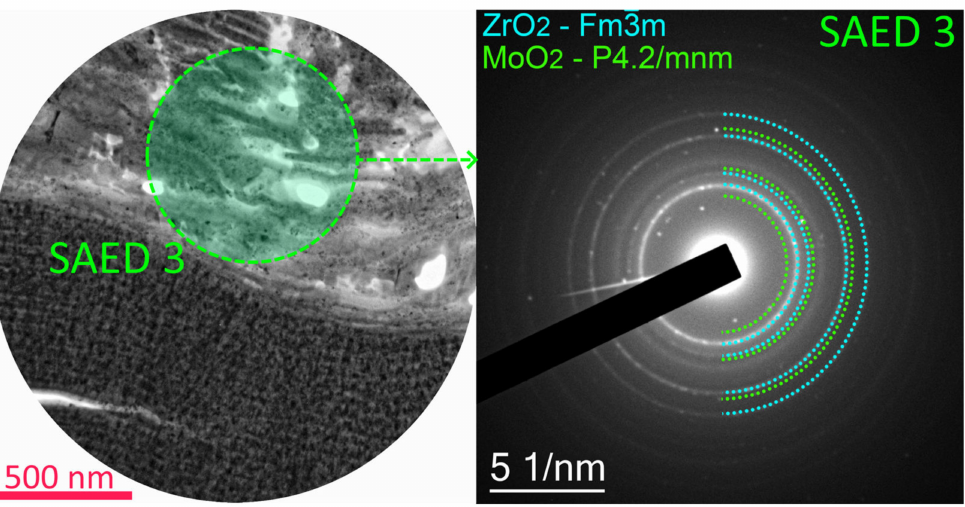
Figure 10. Analysis of the oxidation wear of the coating during the turning of Inconel 718 at the cutting speed of v c = 200